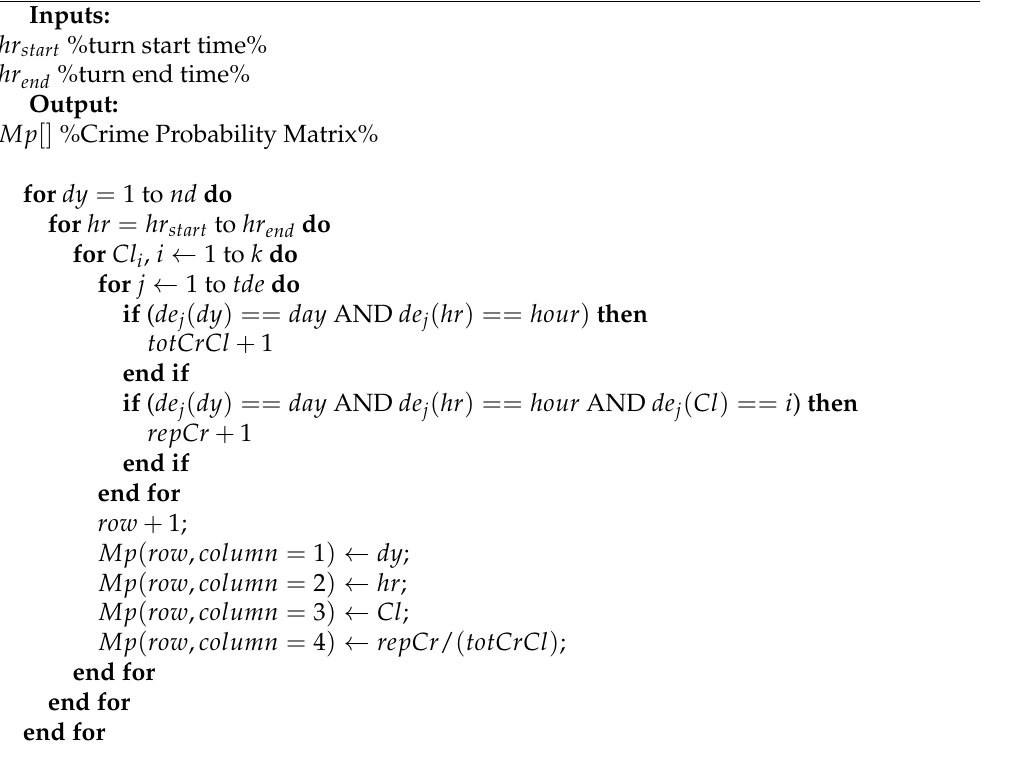
Algorithm 1 Obtaining the Crime Probability Matrix Mp in a